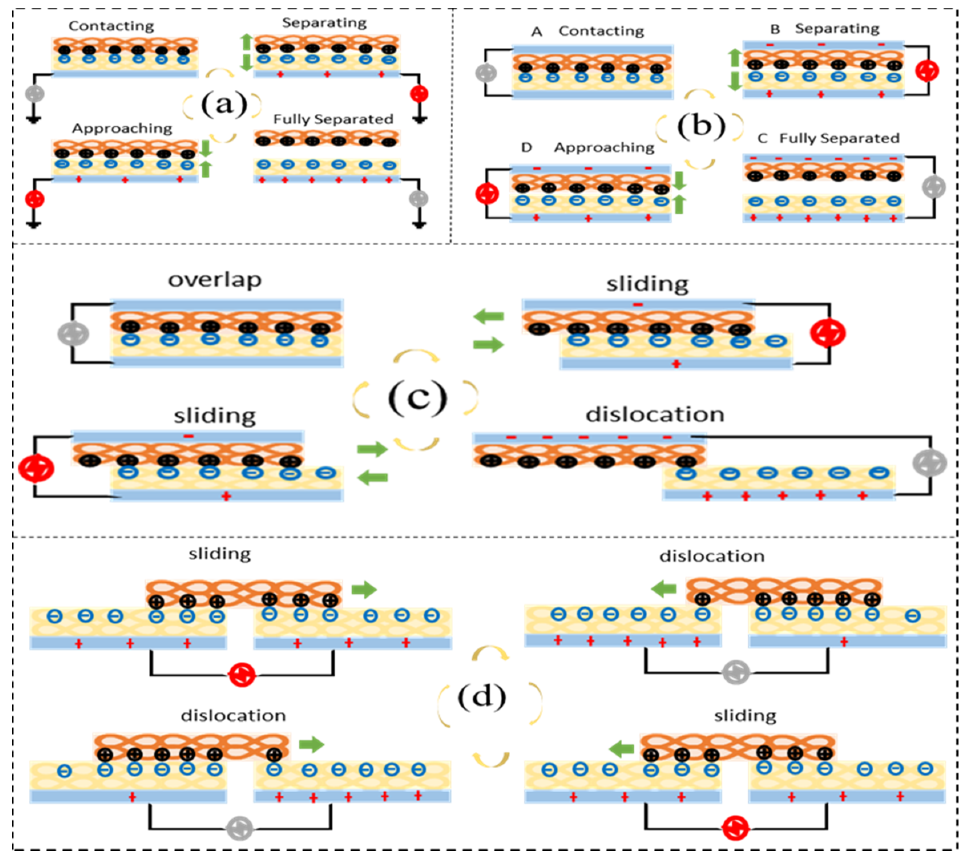
Figure 6. Working mechanisms of textile-based PENGs. ( a ) Single-electrode model. ( b ) Vertical contact-separation model. ( c ) Lateral-sliding model. ( d ) Freestanding triboelectric-layer model.